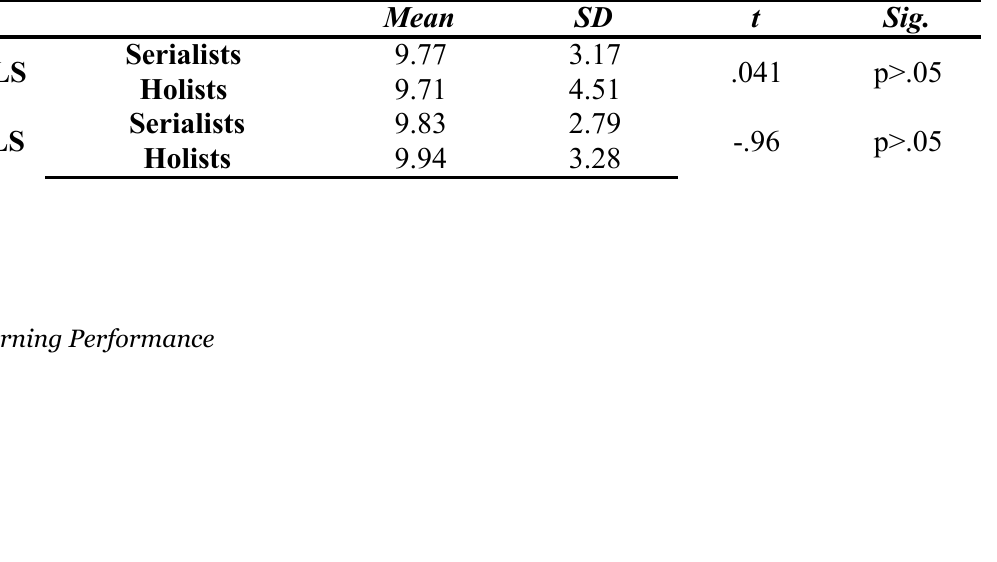
Figure 9. Holist version of PDLS